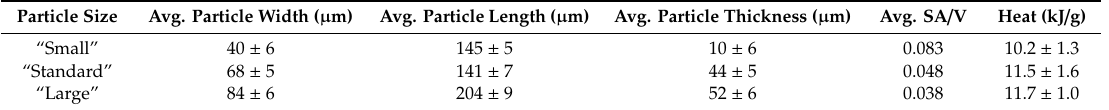
Table 2. Measured sizes and heat produced by burning Al:Zr PVD particles of varying size, using surface-area-to-volume ratio (SA / V) calculated from Equation